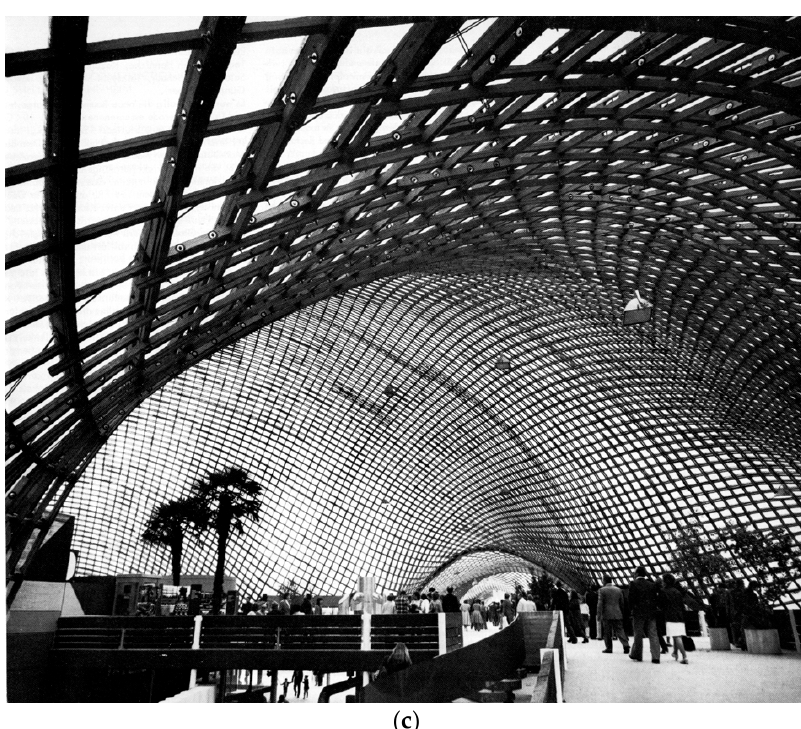
Figure 1. ( a ) The interior of the basilica at La Sagrada Famiglia. Designed by Antoni Gaudi. © Cyril Bays. ( b ) The interior of Los Manantiales Restaurant, Mexico. Designed by Felix Candela. ©